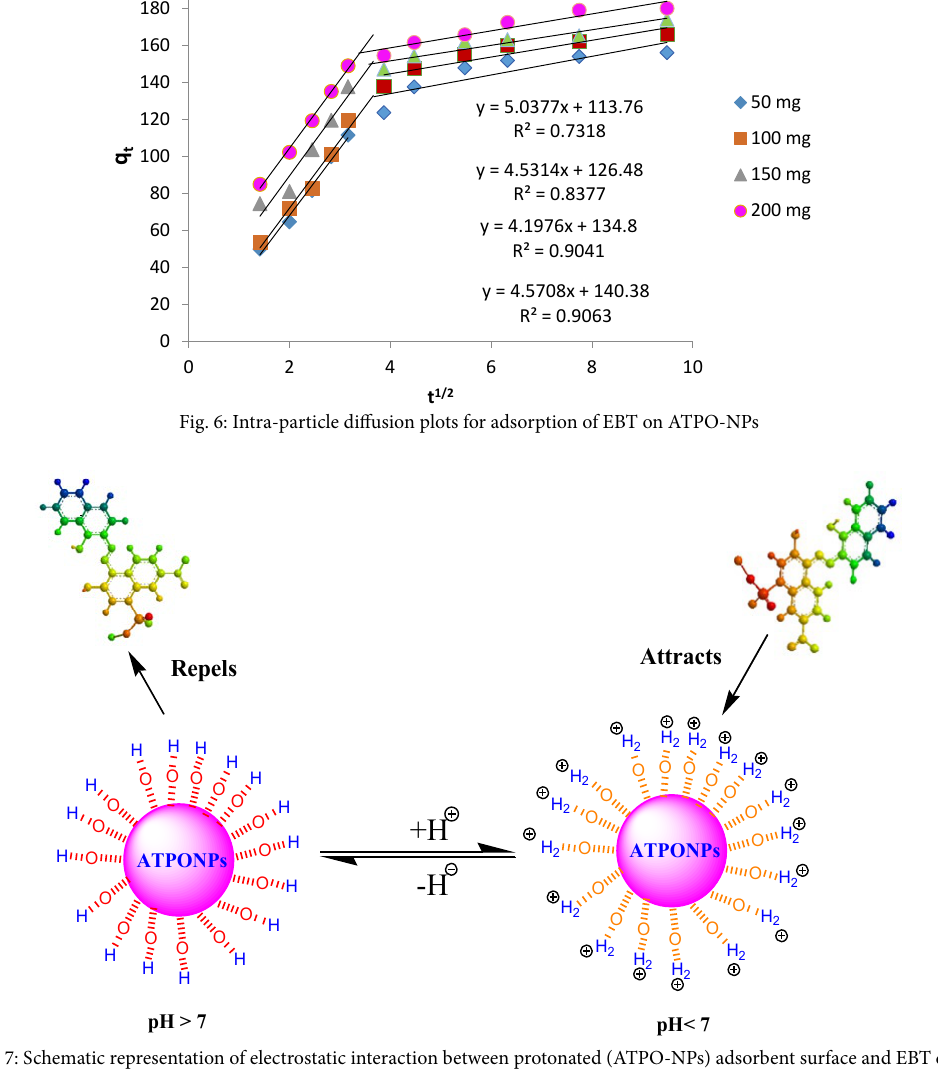
Fig. 7: Schematic representation of electrostatic interaction between protonated (ATPO-NPs) adsorbent surface and EBT dye.